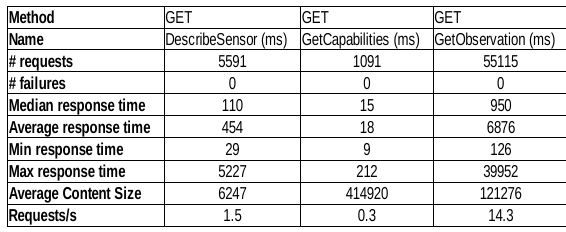
Table 6. PM test results with 200 users (using istSOS-proxy).